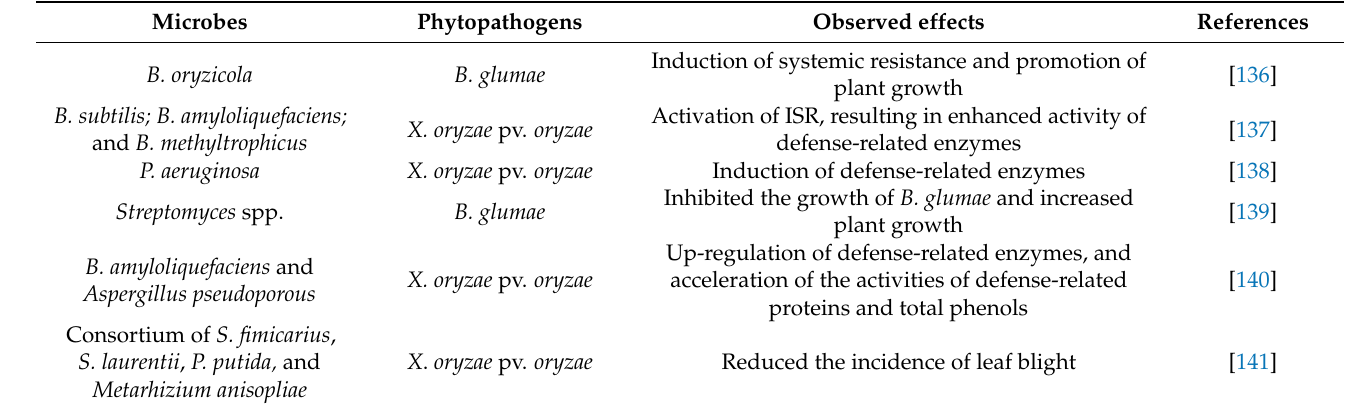
Table 3. Examples of biocontrol effects of beneficial microbes in protecting rice plants from bacterial